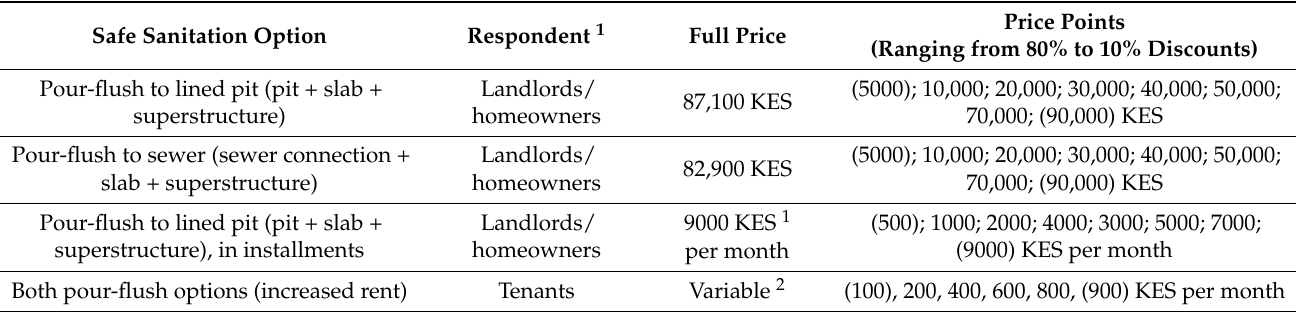
Table 1. Price points used in the double-bound dichotomous choice method. The starting points are listed in the last column; the lowest and highest amounts for the follow-up questions are in